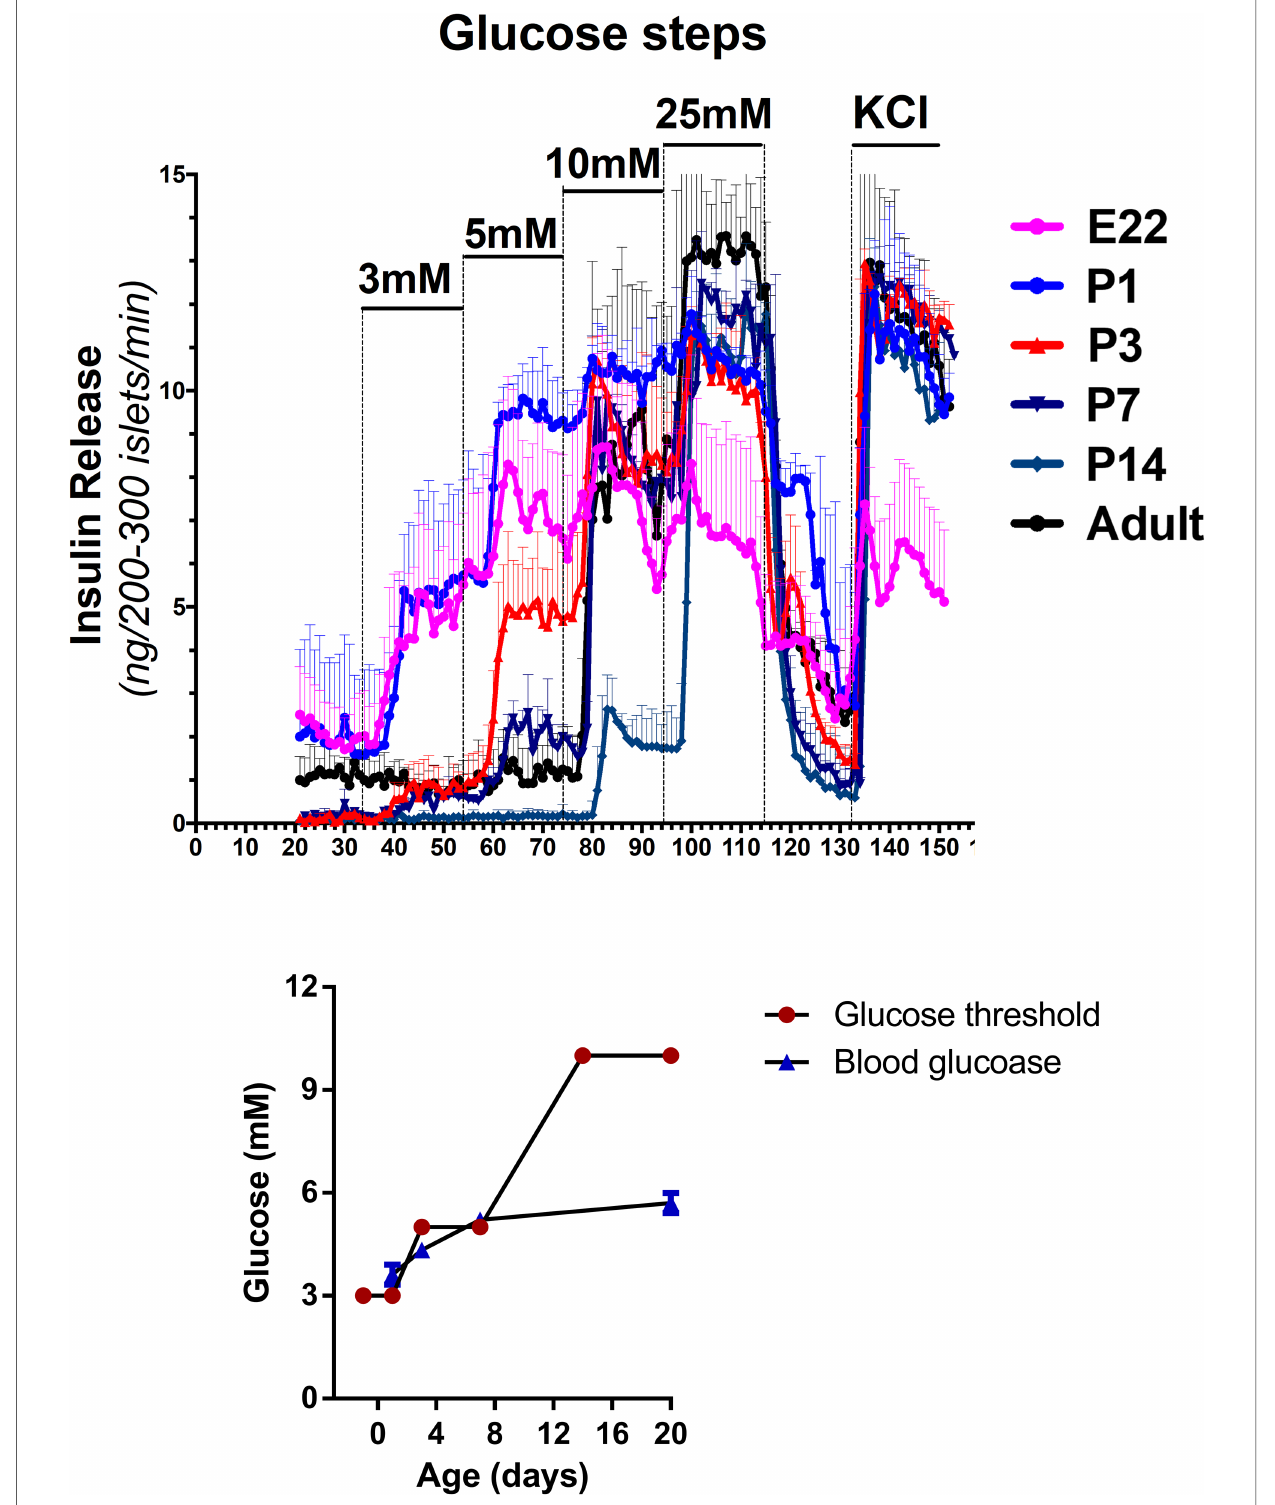
FIGURE 5 Developmental shift in glucose threshold for insulin release in fetal and early neonatal islets. Threshold for glucose stimulated insulin release is lower in fetal and neonatal islets compared to islets from older neonates and adults. Freshly isolated rat islets were perifused with a step-wise ramp stimulation by glucose from 3 mM to 25 mM, followed by maximal insulin release with KCl. Glucose thresholds were de fi ned by the lowest glucose concentration stimulating insulin release greater than baseline glucose-free perifusion. The inset compares the time course of changes in mean plasma glucose concentration and mean glucose threshold for islet insulin